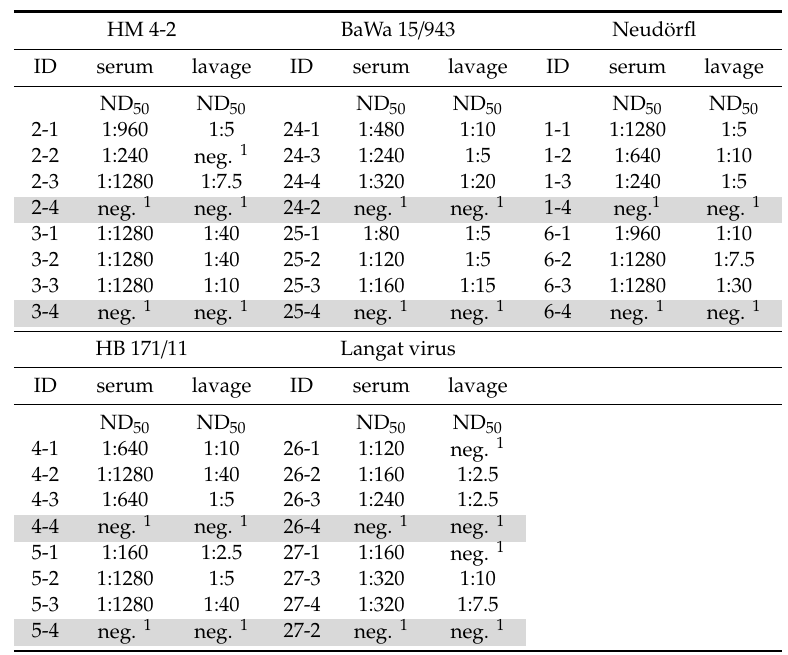
Table 3. Results of the microneutralization assay comparing the usage of lavage samples to serum samples for the animals that had been inoculated with either the Neuddörfl, HM 4-2, HB171 / 11, or BaWa 15 / 943 TBEV-Eu strain or Langat virus. In-contact animals are shaded in grey. ND 50 : 50% neutralizing